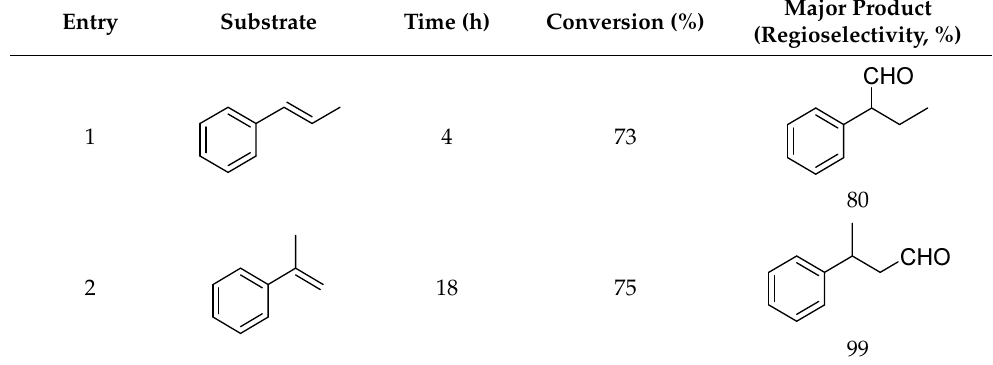
Table 2. Results of catalytic hydroformylation of ( E )-prop-1-en-1-ylbenzene and prop-1-en-2-ylbenzene using Rh/ L2 catalyst a .